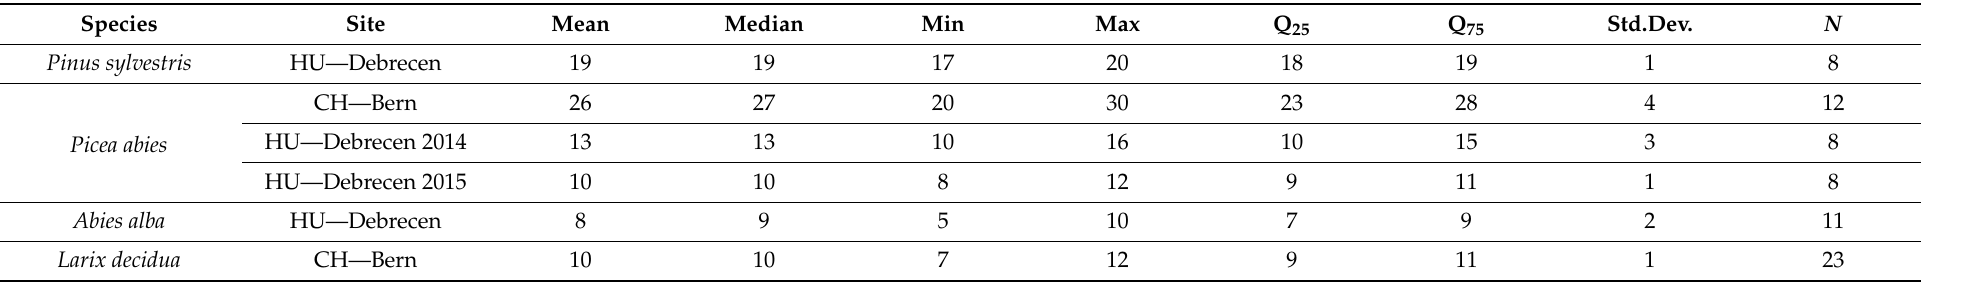
Table 1. Cellulose yield (%) from mature needles applying the Jayme-Wise extraction method. Basic statistics include mean, median, minimum value (min), maximum value (max), lower (Q 25 ) and upper quartiles (Q 75 ), and standard deviation (Std.Dev.). N denotes the number of samples. In the ‘Site’ column the first two letters denote the Alpha-2 country codes as described in the ISO 3166 international standard followed by the study site name and a year of harvest if applicable. Species Site Mean